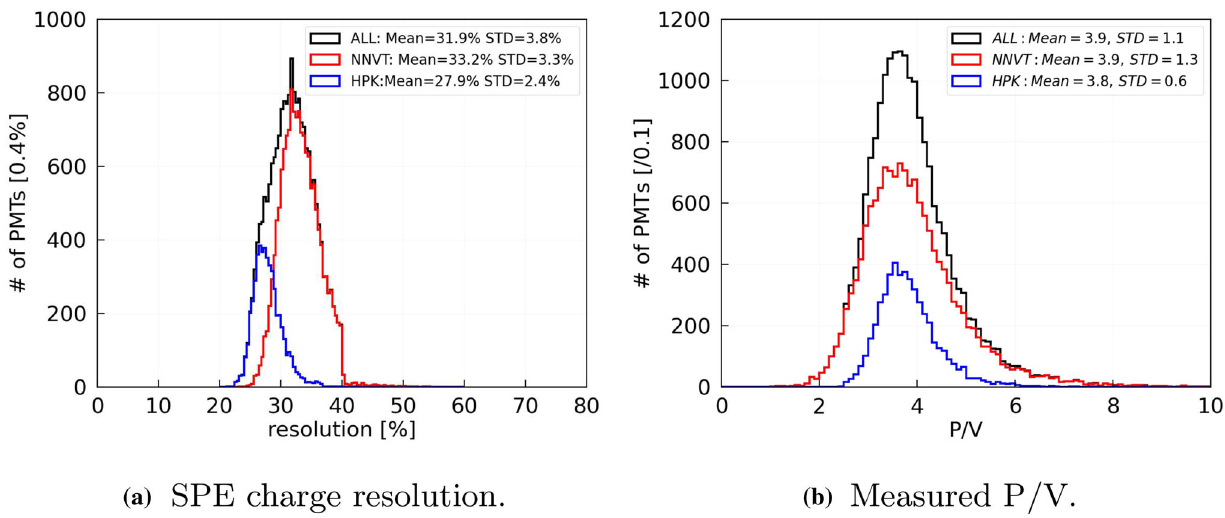
Fig. 15 Left: SPE charge resolution of all qualified PMTs; right: measured P/V of all qualified PMTs. Black: all PMTs; red: NNVT; blue: HPK. Please note that the requirement of the charge resolution is relaxed for a few NNVT tubes for the JUNO veto detector, which is higher than